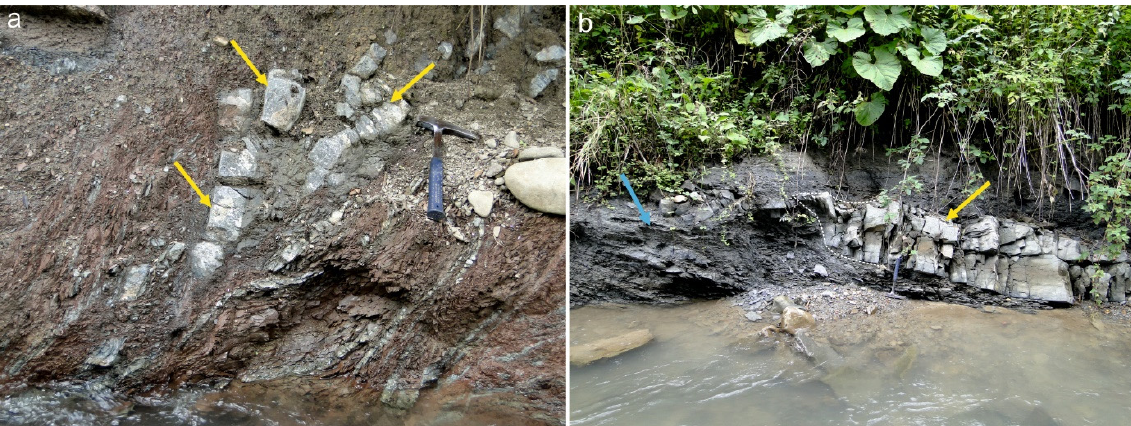
Figure 8. Deformed rocks at the hinge zone of the thrust related fold in the Ra č a Unit: ( a ) disrupted fragments of thin sandstone layers (indicated by arrows) randomly included in the greenish-red shaly matrix, ( b ) grey shaly matrix (blue arrow) enclosing a fractured sandstone block (yellow arrow) preserving dip direction and dip angle similar to the dip of the fold limb.